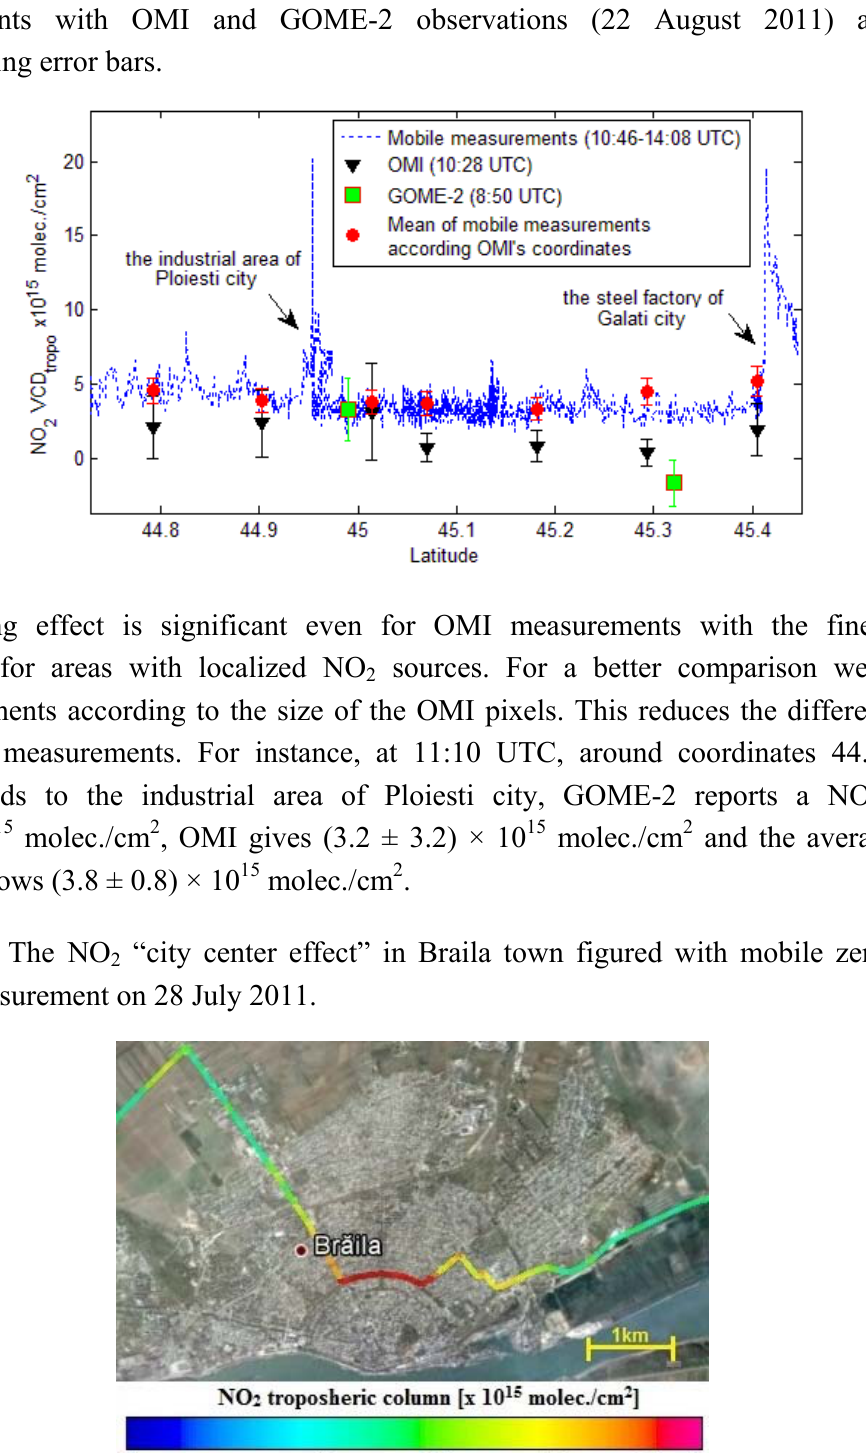
VCD deduced from mobile DOAS zenith-sky 2